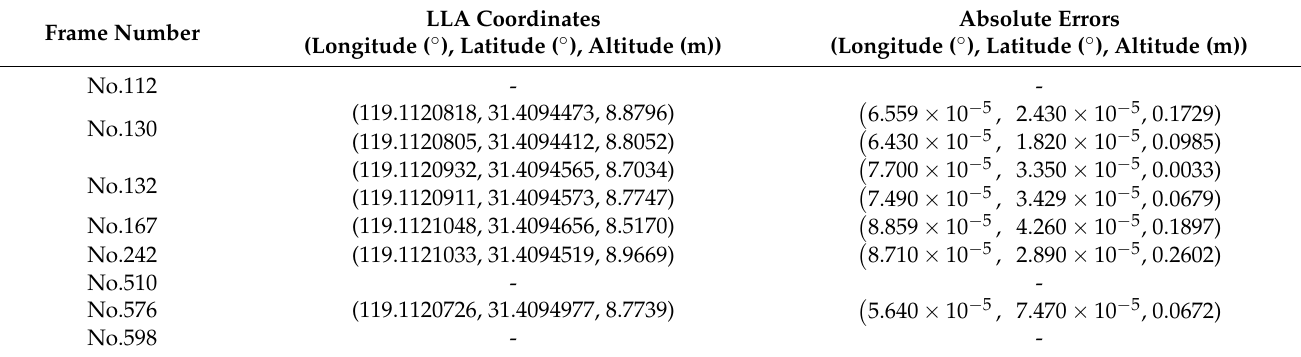
Table 3. The coordinates of the fire area detected from frames. LLA Frame Number